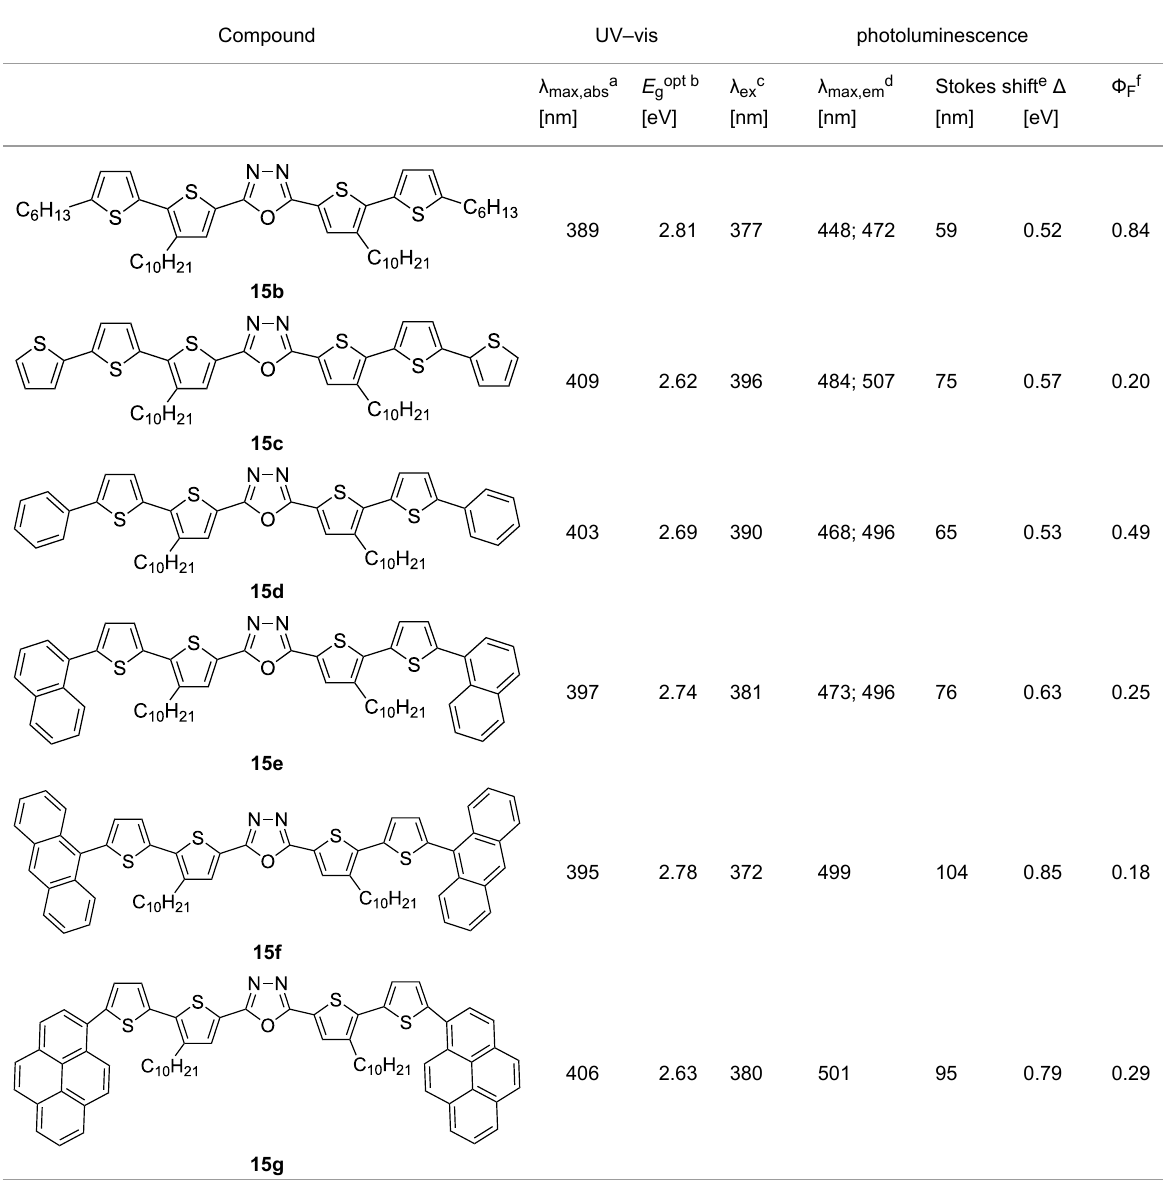
Table 2: Spectroscopic and luminescent properties of 5'-aryl-substituted 2,5-bis(3-decyl-2,2'-bithiophen-5-yl)-1,3,4-oxadiazoles 15b – g in